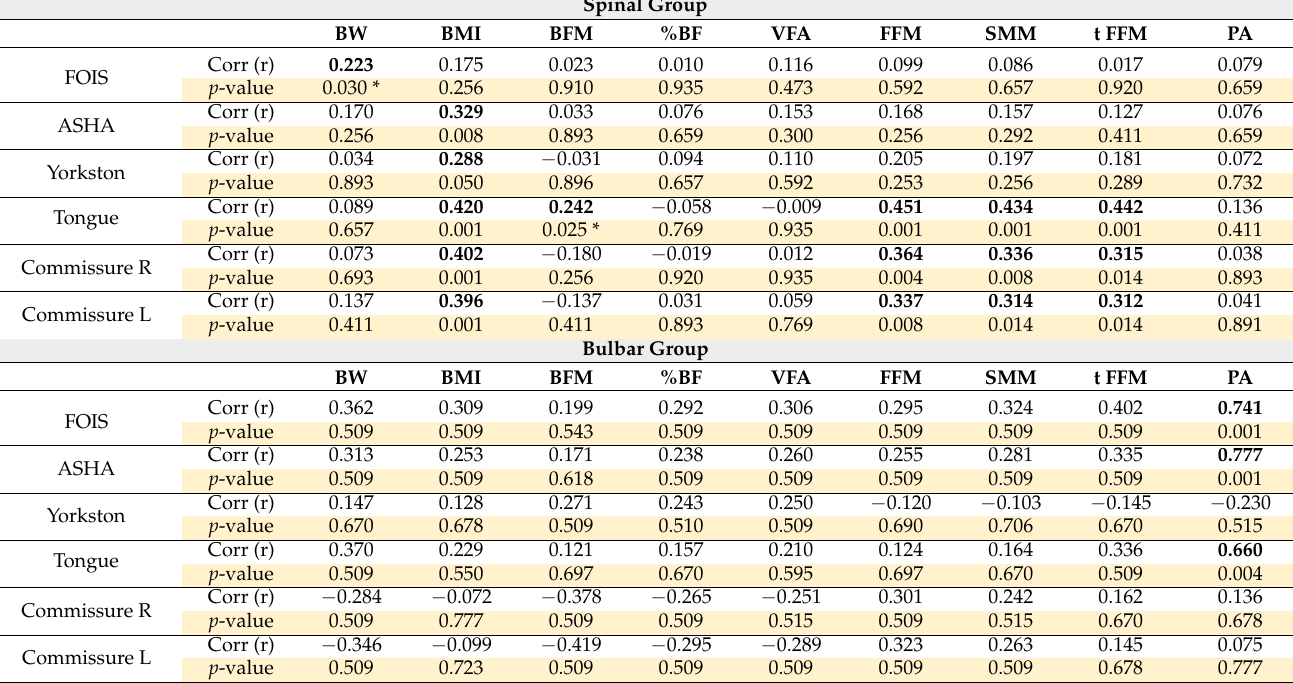
Table 3. Spearman’s correlation coefficients between body composition and clinical speech therapy assessment, according to diagnostic